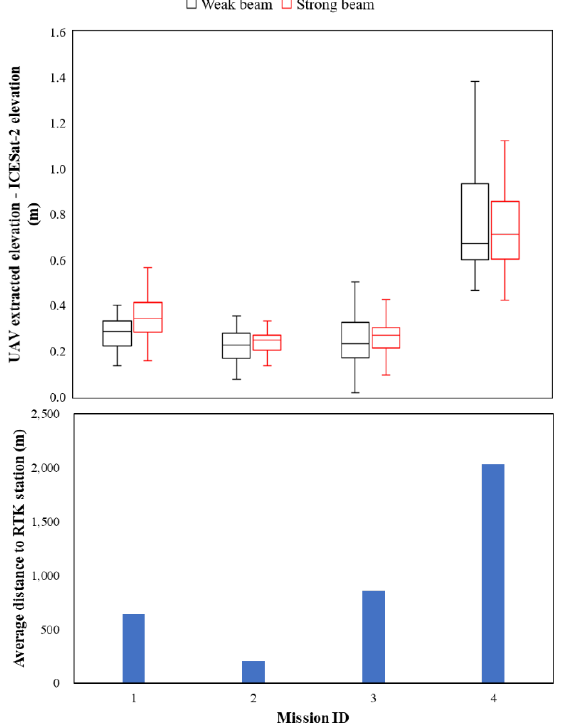
Figure 7. Boxplots of the UAV extracted elevation minus the ICESat-2 ATL06 elevation and corresponding average distance to RTK station for each survey. Outliers are not show in the